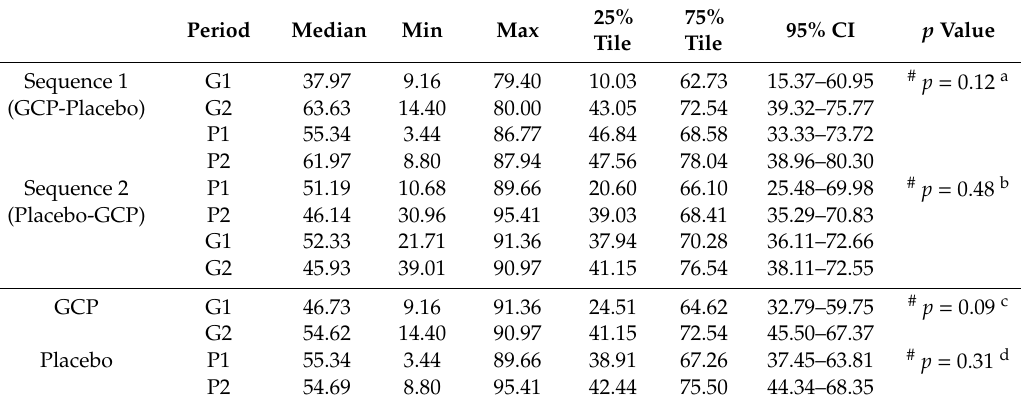
Table 5. VAS values for the question, “How is your secretion of